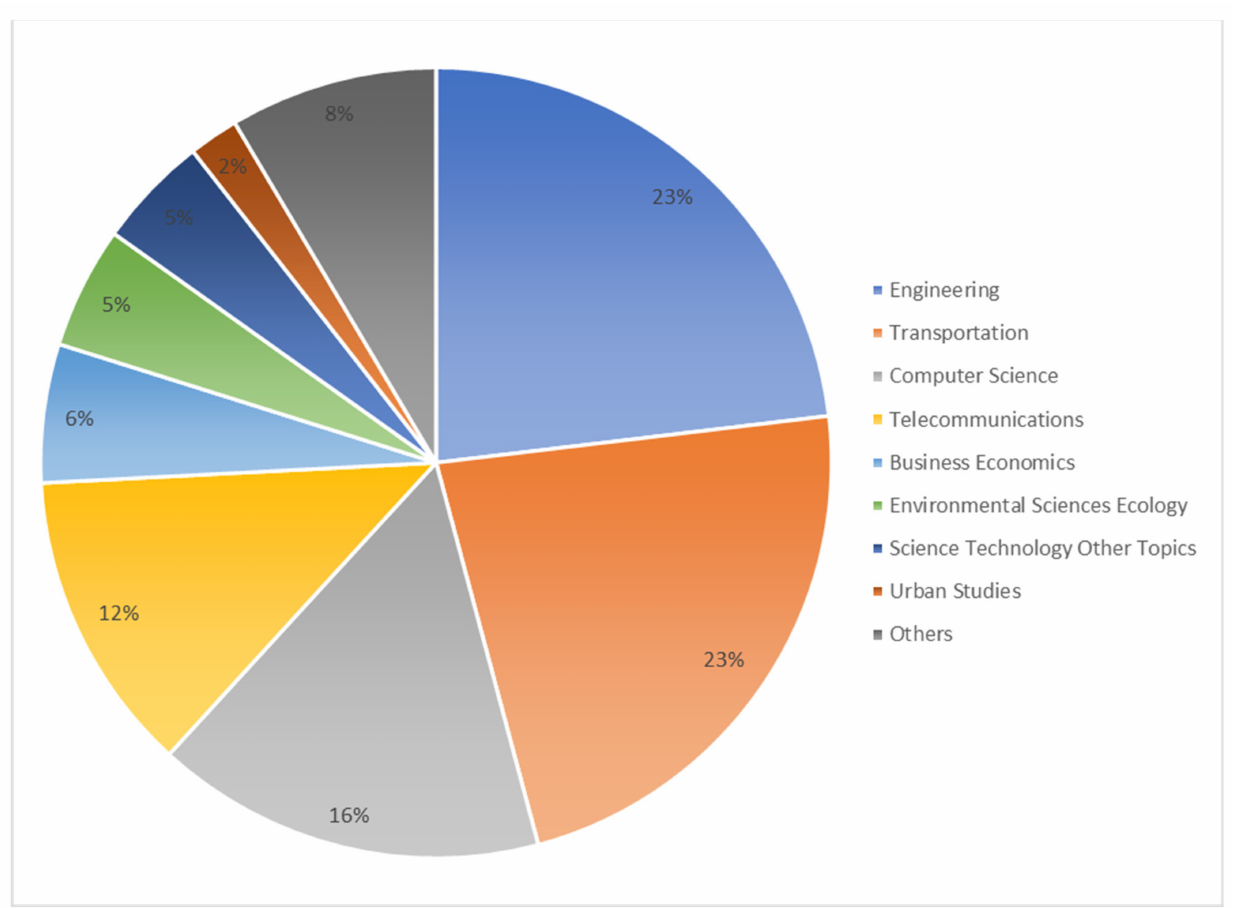
Figure 4. Primary Research Areas for published works. Illustration by